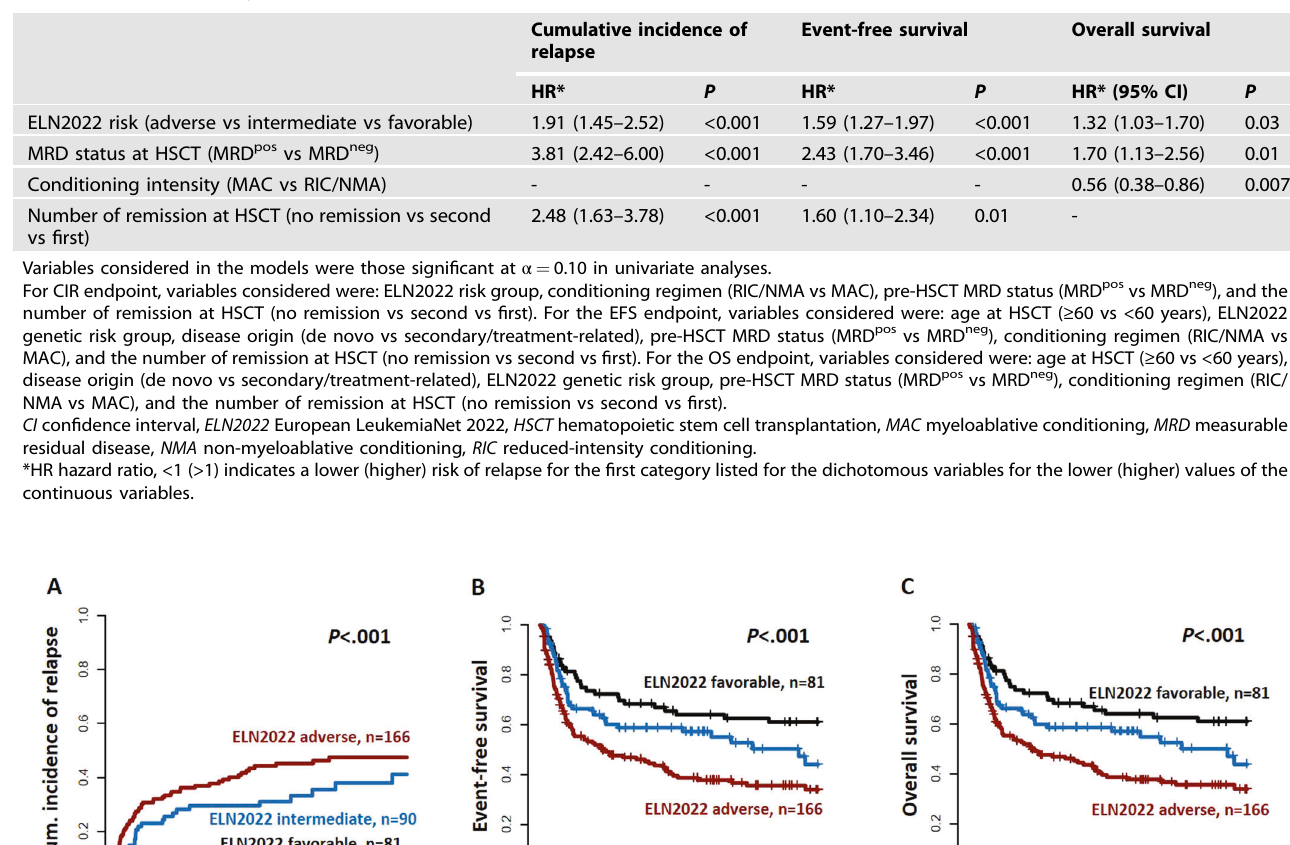
Table 2. Multivariate analysis.